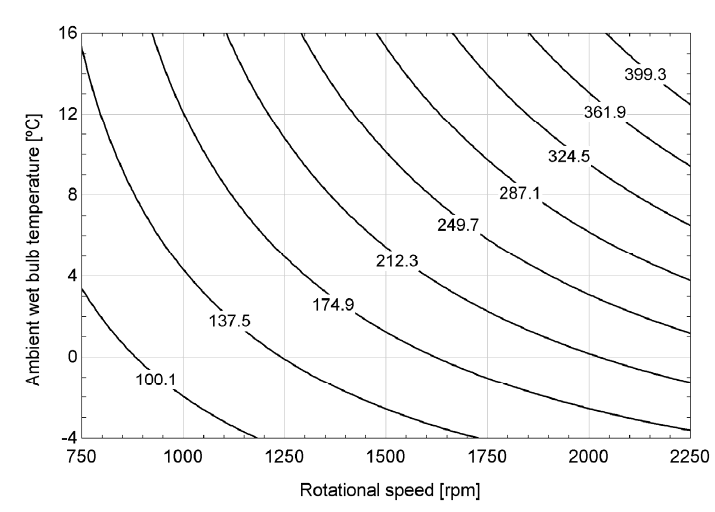
Figure 6. Iso-lines of heating capacity of the ASHPWH.